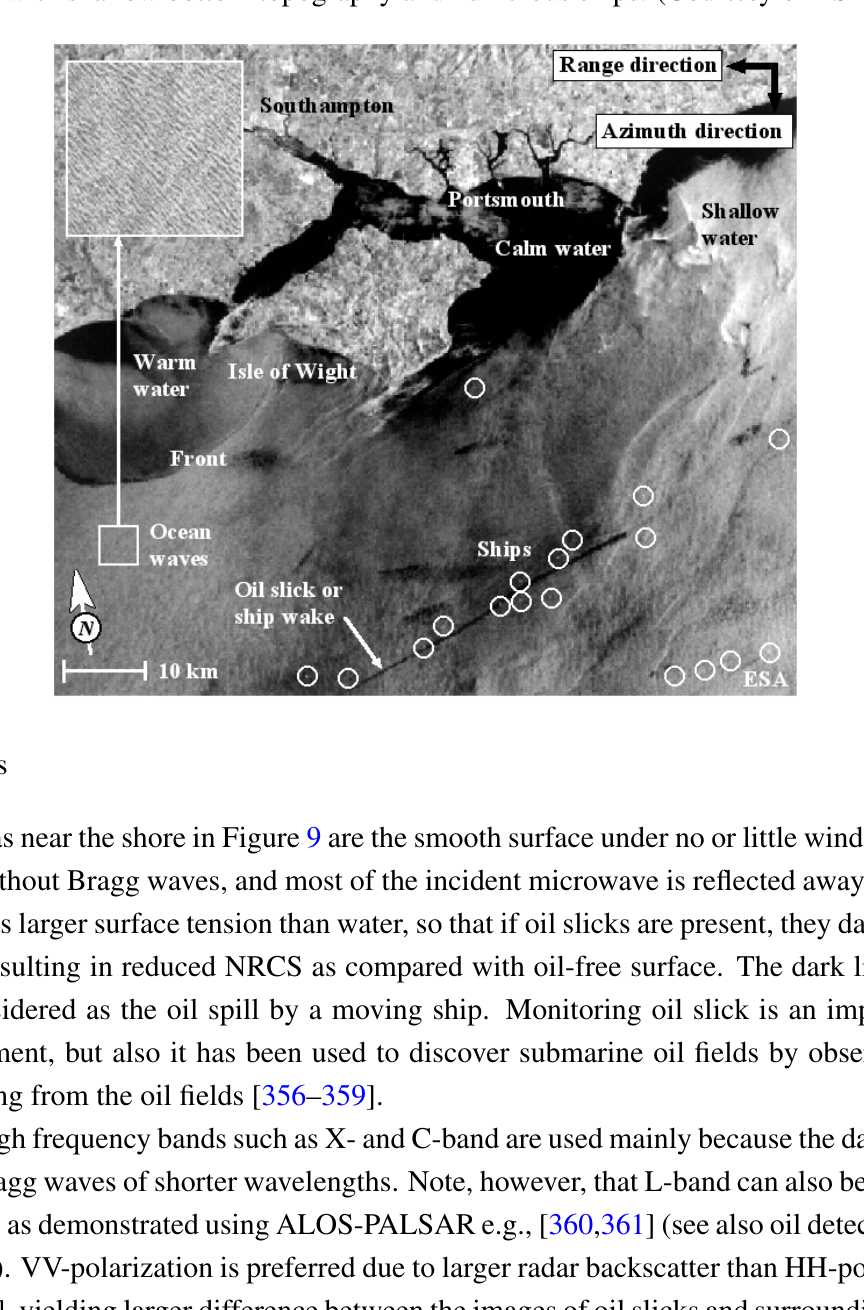
Figure 9. ERS-1 C-band SAR image of the English Channel, where the scene center is approximately at (N: 50.57 ◦ , W: 1.17 ◦ ). Several oceanic features can be seen, including ocean waves, oil slick, warm water mass, front, wind-sheltered calm sea, rough sea associated with shallow bottom topography and numerous ships. (Courtesy of